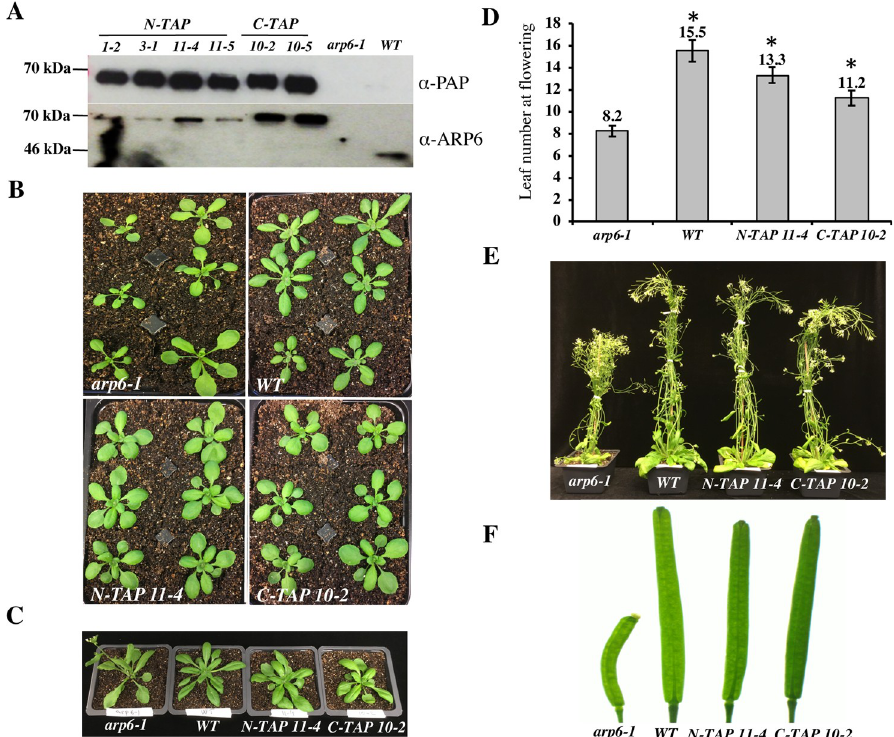
Fig 1. N-TAP-ARP6 and C-TAP-ARP6 transgenes rescue the arp6-1 phenotype. (A- upper blot) T 2 plants homozygous for N-TAP- or C-TAP-ARP6 transgenes express a fusion protein with the expected size of 67.5 kDa. The fusion protein is specifically detected only in transgenic plants and not in arp6-1 or WT plants using a peroxidase anti- peroxidase (PAP) soluble complex, which binds the protein A moiety of the TAP tag. (A- lower blot) The same protein extracts as in the upper blot were probed with a monoclonal ARP6 antibody. ARP6 presence is specifically detected in all transgenic plants as a 67.5 kDa fusion protein band compared to the 44 kDa ARP6 band in WT plants, and is absent in arp6-1 mutant plants. The ARP6 antibody reacts less strongly with N-TAP-ARP6 , most likely because the antibody recognizes the N-terminal region, which is adjoined to the TAP tag in this fusion. (B) Transgenic plants look more similar to WT plants than arp6-1 plants, with more compacted, non-serrated rosette leaves. (C) Early flowering phenotype is rescued in transgenic plants when compared to the arp6-1 . (D) The average number of rosette leaves of N-TAP-ARP6 and C-TAP-ARP6 transgenic plants at flowering is significantly higher than in arp6-1 (n = 6 for WT and arp6-1 , and n = 12 for N-TAP 11–4 and C-TAP 10–2 ). Asterisks indicate significant differences from arp6-1 plants with p < 0.001, calculated using unpaired t-tests. (E) The loss of apical dominance defects of arp6-1 plants are rescued in N-TAP-ARP6 and C-TAP-ARP6 transgenic plants. (F) The fertility defects of arp6-1 plants are rescued in N-TAP 11–4 and C-TAP 10–2 transgenic